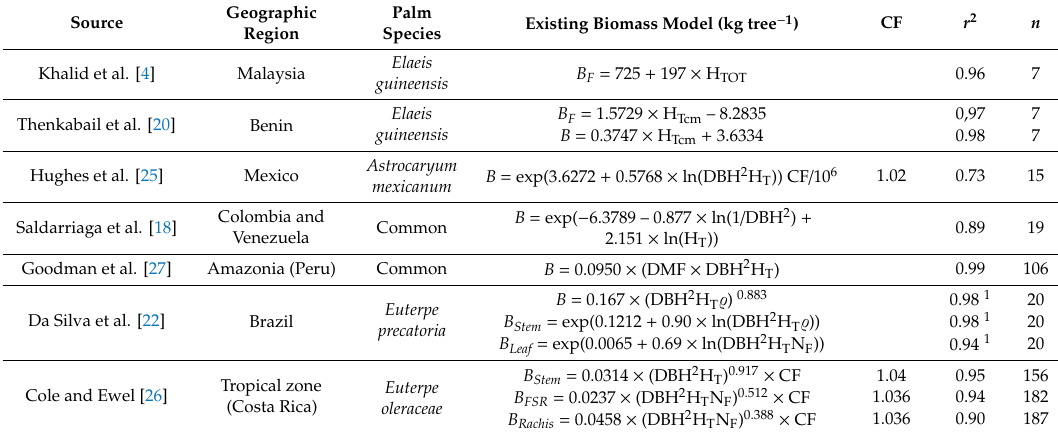
aboveground fresh biomass of an oil palm (kg); B Stem = stem biomass (kg); N F = number of leaves; B FSR = leaf biomass without rachis (kg); B Rachis = rachis biomass (kg); DBH = diameter at breast